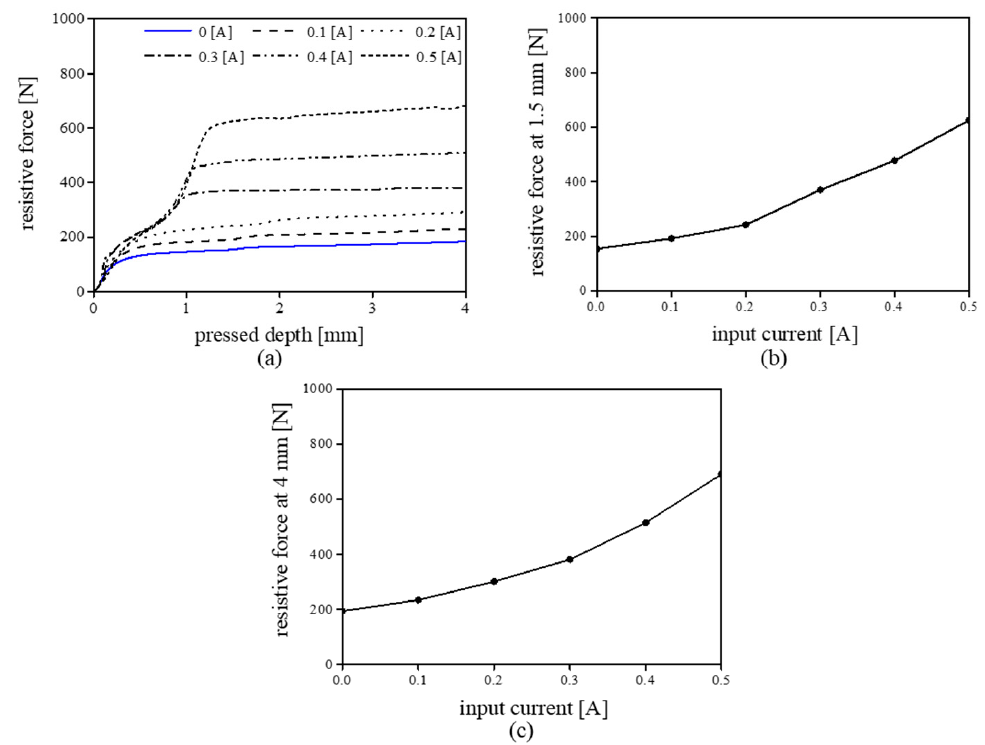
Figure 12. Experimental result of the proposed actuator: ( a ) Measured resistive force as a function of the proposed actuator’s stroke (head position); ( b ) Measured resistive force at 1.5 mm stroke; ( c ) Measured resistive force at 4 mm stroke.